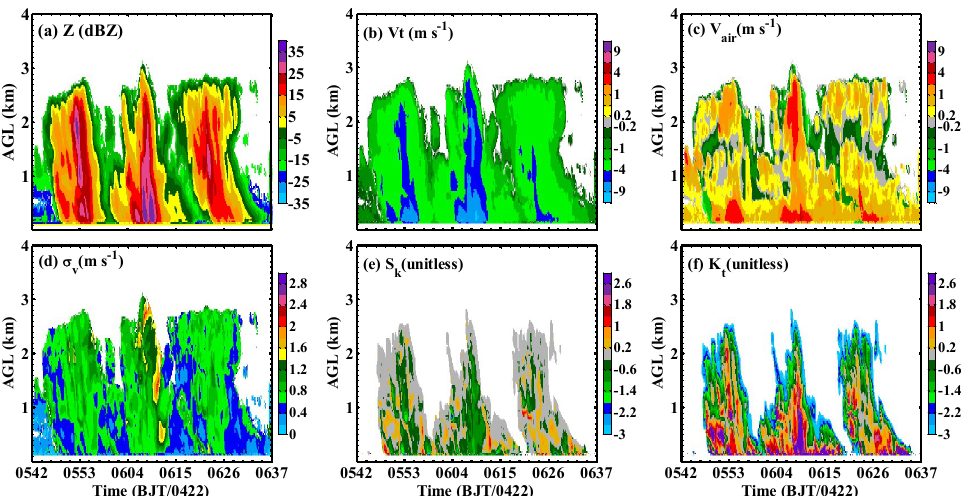
Figure 12. Time–height cross-sections of the MMCR measurements observed from 05:42 to 06:37 BJT on